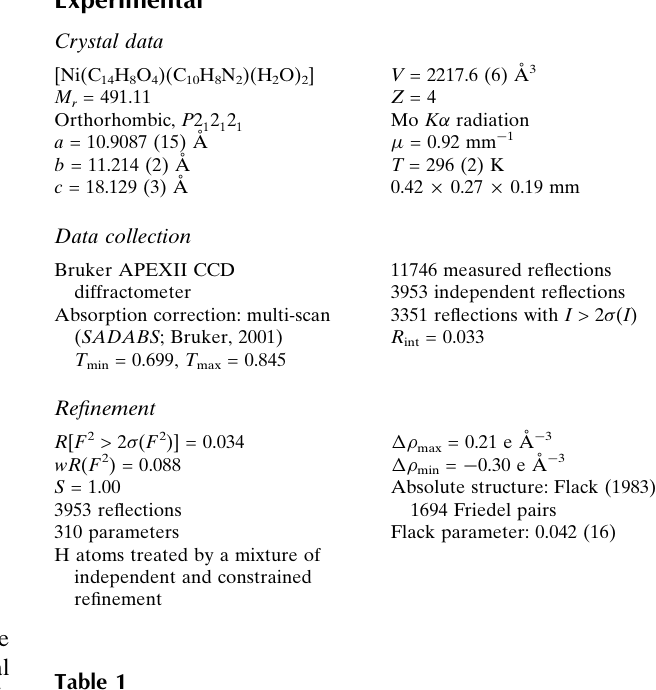
Hydrogen-bond geometry (A˚ , (cid:4)